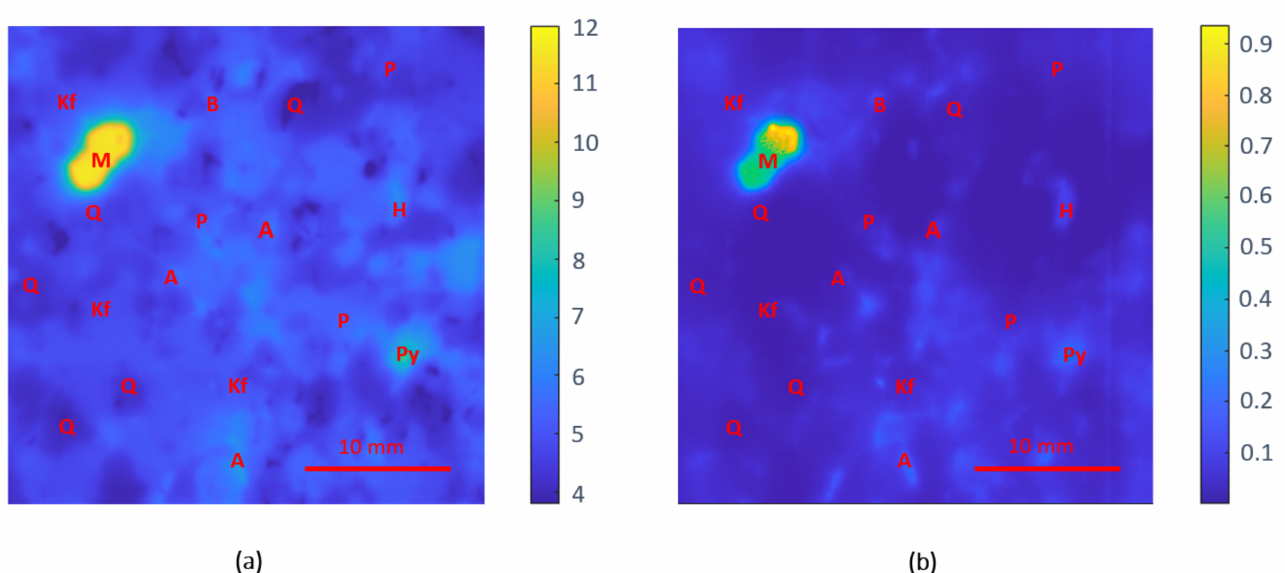
Figure 7. Dielectric images of the gneiss specimen: ( a ) dielectric constant response and ( b ) loss factor results (Q—quartz; Kf—potassium feldspar; P—plagioclase; B—biotite; A—aegirine-augite pyroxene; H—hornblende; M—magnetite;